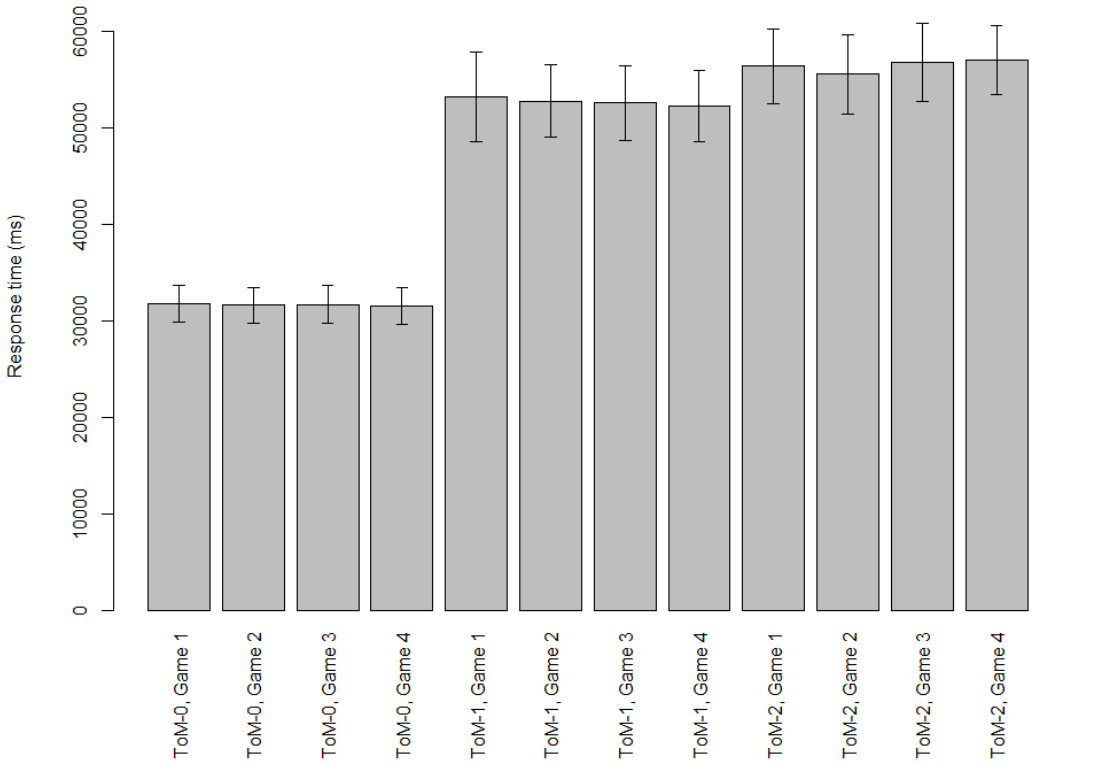
Figure 8. Reaction times in milliseconds for the automatically generated theory-of-mind cognitive models in Games 1–4. Zero-order theory-of-mind agents (ToM 0 ) do not take the opponent’s goals and beliefs into account; first-order agents (ToM 1 ) take the opponent’s goals and beliefs about world facts into account; second-order agents (ToM 2 ) in addition take the opponent’s beliefs about the focal agent’s mental states into